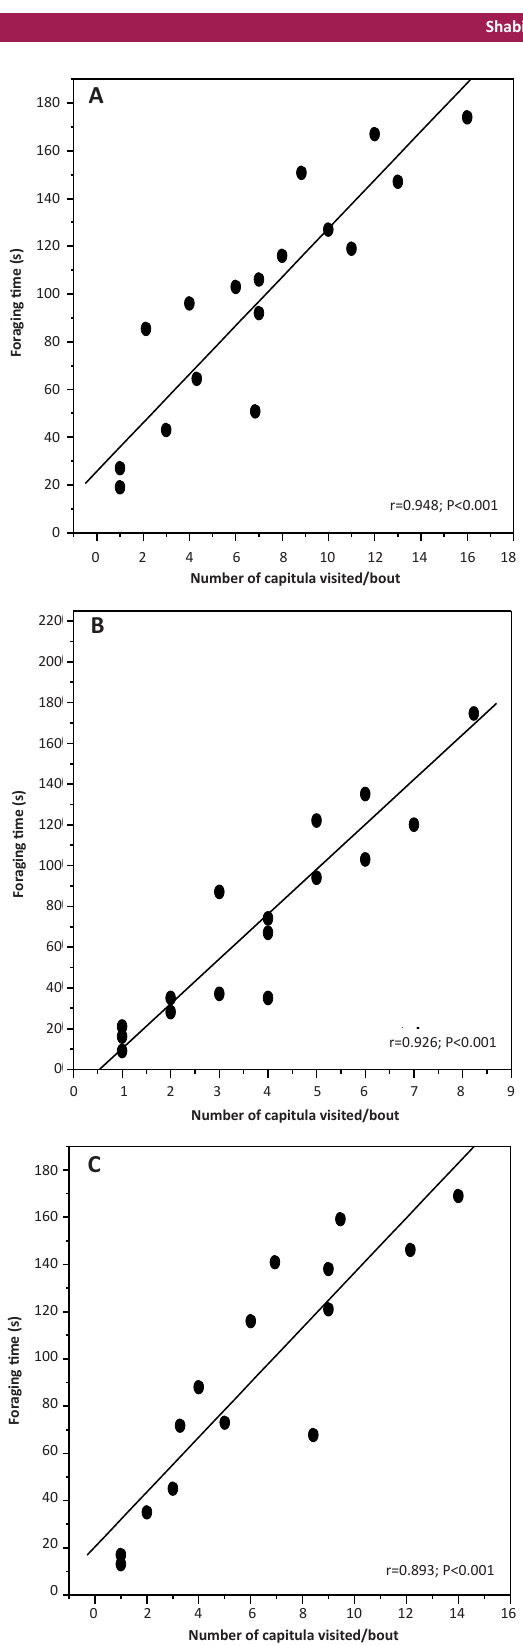
Figure 1. Correlations between the number of inflorescences visited per bout and foraging time among I. racemosa plants at the three studied populations (A) Farozpora (B) Gulmarg and (C)